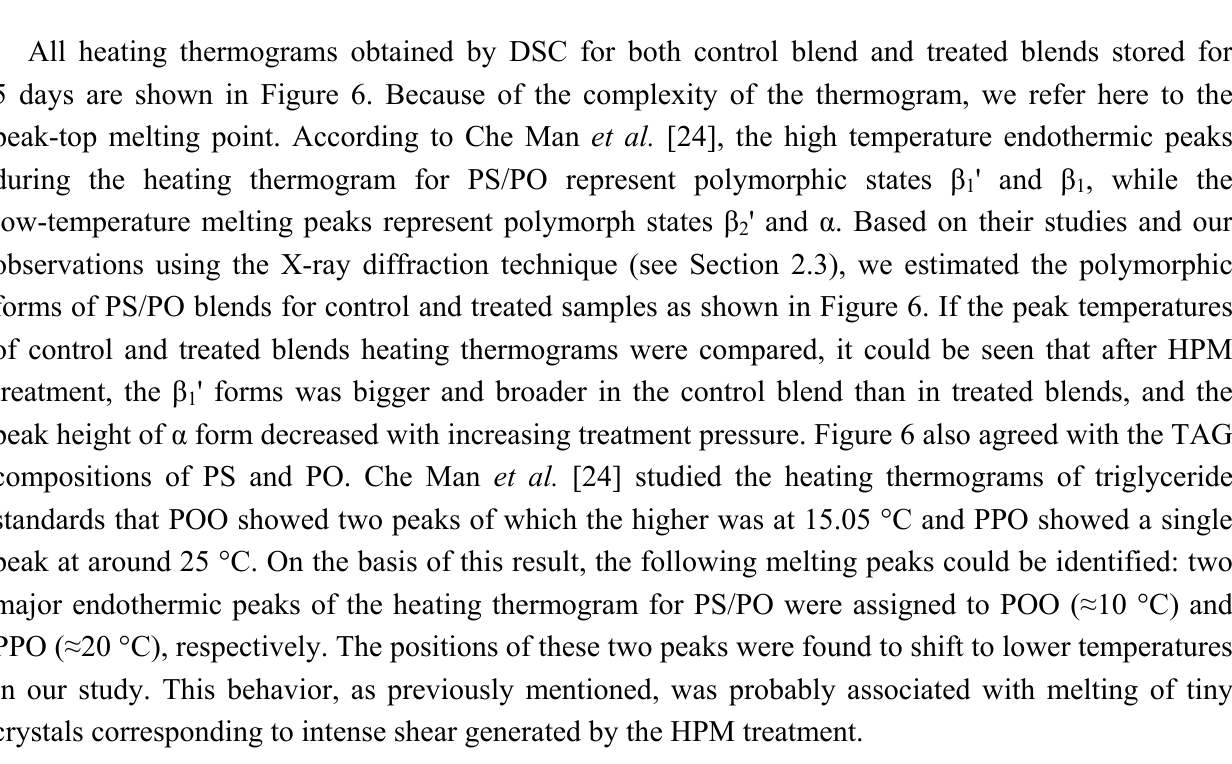
Figure 6. Dynamic heating thermograms (5 °C/min) for control blend and treated blends stored for 5